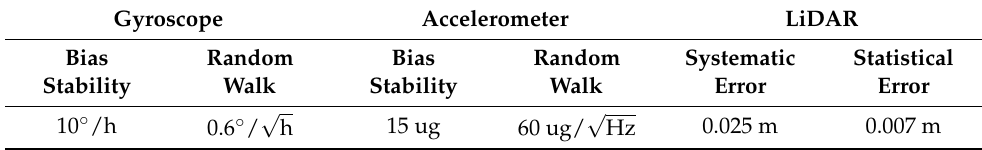
Table 1. Specifications of the